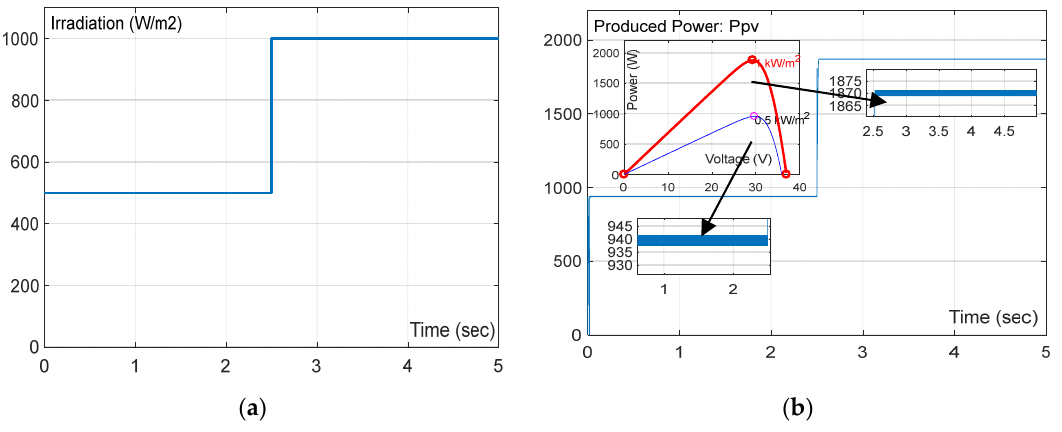
Figure 16. ( a ) Irradiation profile (W/m 2 ) and ( b ) produced power P pv.